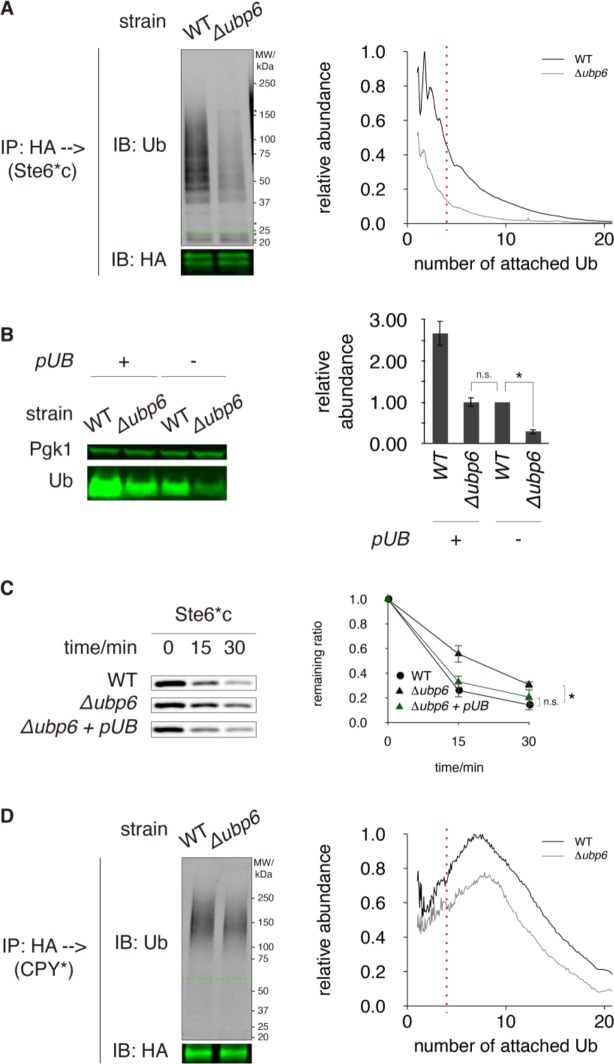
CytoQC is rescued by restoring free ubiquitin abundance in Δubp6.(A) Ubiquitination of Ste6*c, a cytosolic misfolded protein. Proteins were extracted under non-reducing condition to preserve unconventional ubiquitination on cysteine residues. Ste6*c was immunoprecipitated (IP) using anti-HA affinity matrix, fractionated by SDS-PAGE (non-reducing) and visualized by immunoblotting against ubiquitin (greyscale) and HA (green). The amount of proteins loaded for IP was normalized based on the level of non-ubiquitinated proteins. Ubiquitinated proteins were observable as smear and ladder in anti-ubiquitin blots. The positions of non-ubiquitinated substrates are indicated by green dashed lines (—). Non-specific bands, which originate from HA affinity matrix, are indicated by asterisks (*). Left: representative blots. Right: quantification of the left. The number of ubiquitin molecules attached to a ubiquitinated species was calculated from the latter’s molecular weight and plotted along the horizontal axis. The abundance of each species, plotted along the vertical axis, was calculated by normalizing the strength of fluorescent signal to the number of ubiquitin moieties and then to the abundance of non-ubiquitinated substrate. The red dashed vertical line indicates where the ubiquitin chain length is 4, the minimum threshold for high-affinity interaction with proteasome. (B) Abundance of free (mono-)ubiquitin in WT and Δubp6 with or without ubiquitin overexpression (pUB). Experiments were performed under non-reducing condition as in (A). Pgk1 was probed as a loading control. (C) Degradation of Ste6*c in Δubp6 + pUB, shown along with degradation in WT and Δubp6 (without pUB). Ste6*c was pulsed-chased as in Fig 2. (D) Ubiquitination of CPY*, a misfolded ER luminal protein. Similar to (A).